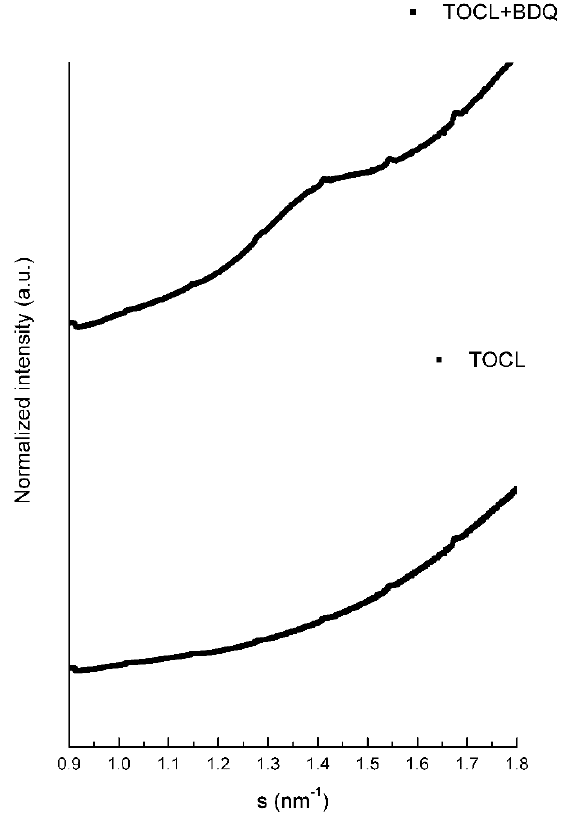
Figure 3. WAXS diffraction patterns of TOCL and TOCL with BDQ at 5% molar ratio at 10 °C.